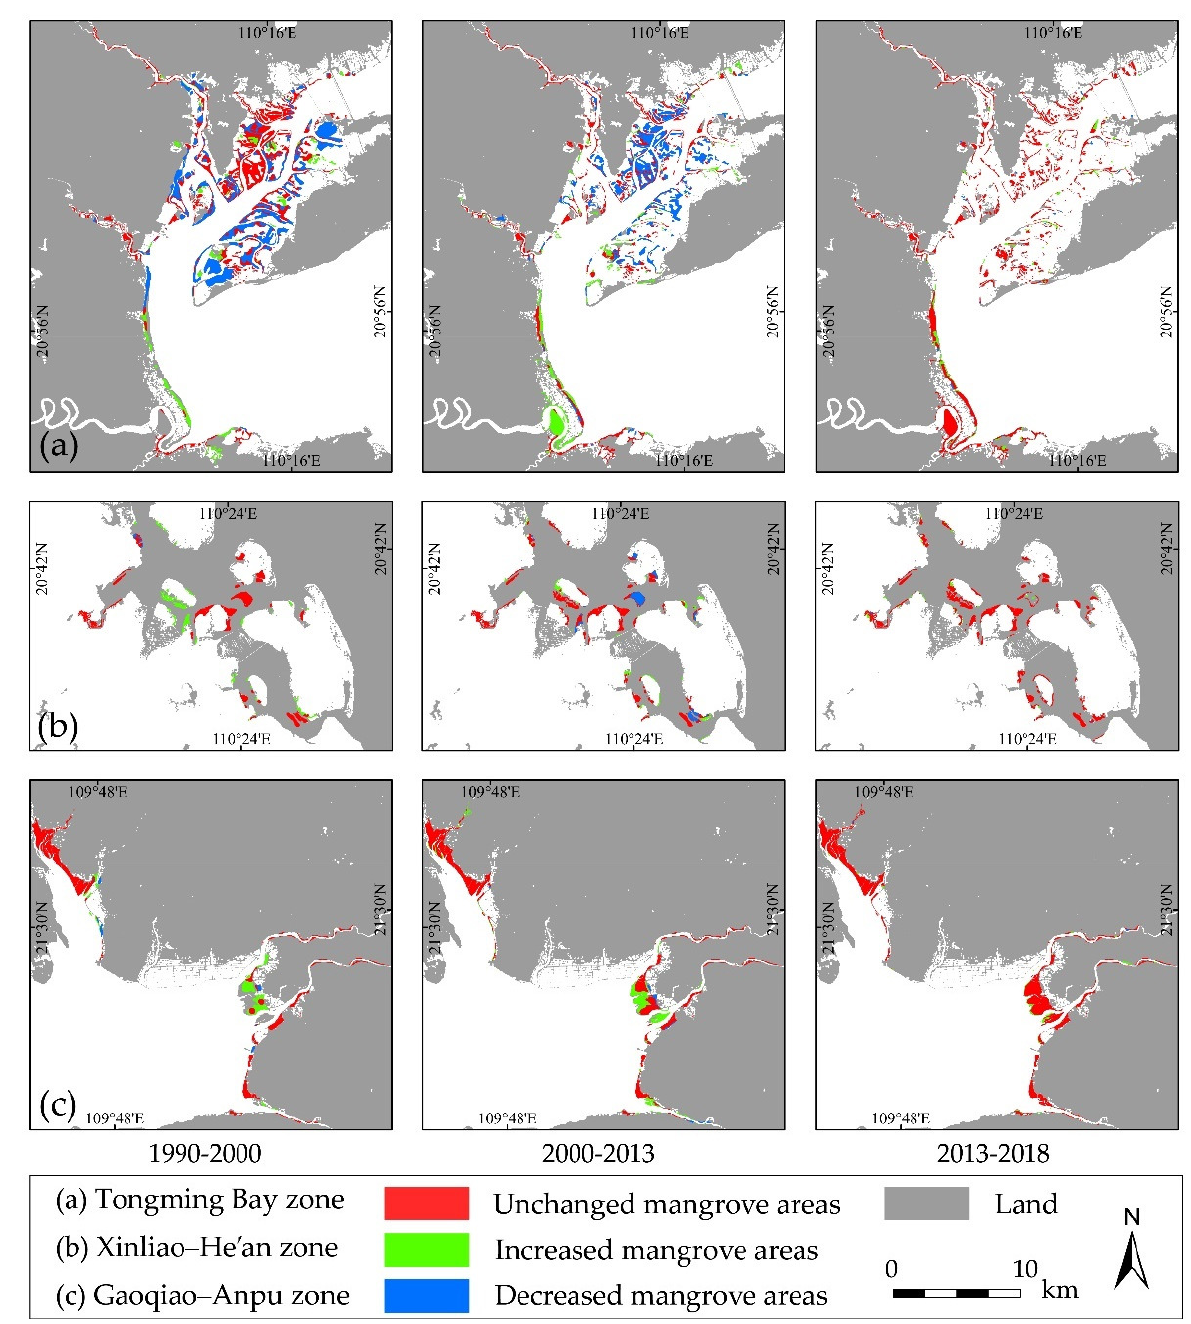
Figure 4. Changes of mangrove area in ( a ) the Tongming Bay zone, ( b ) the Xinliao–He’an zone, and ( c ) the Gaoqiao–Anpu zone after